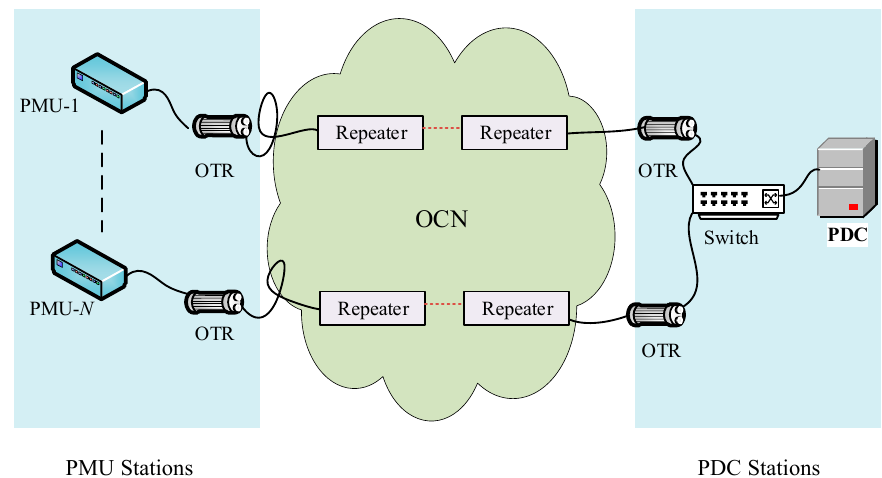
Figure 1. Dedicated synchrophasor communication network.